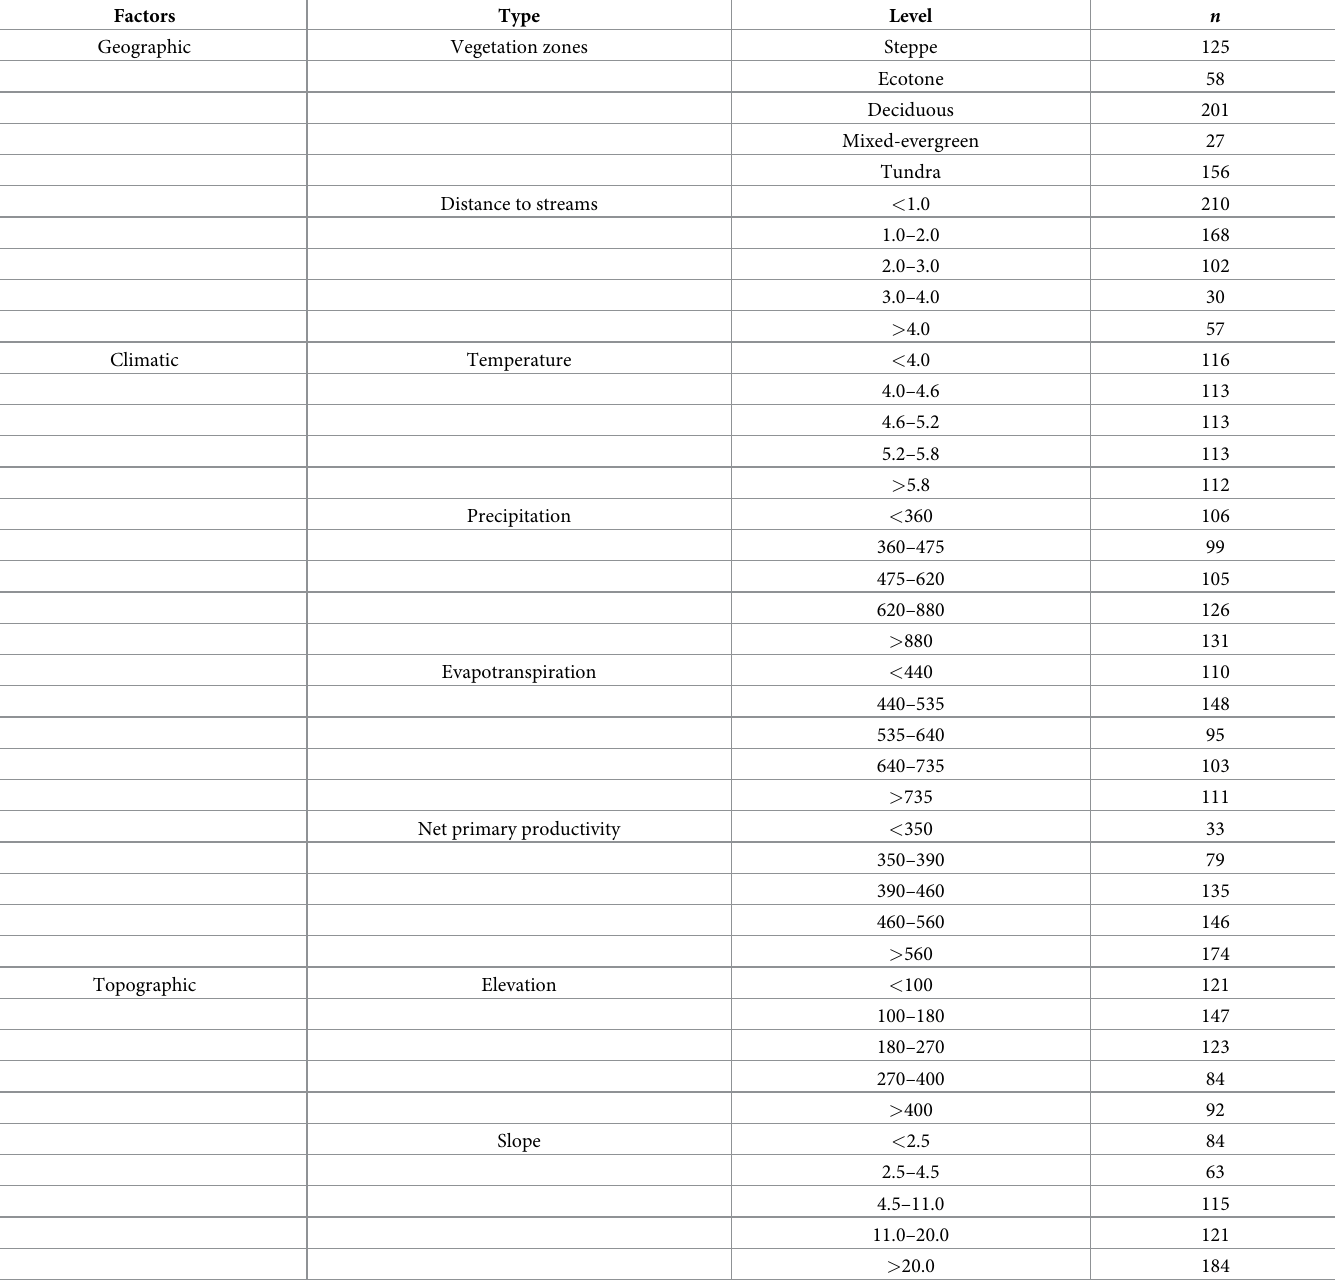
Table 1. Hexagon quantity (total of 567 for the whole study area) obtained for each level of the analyzed geographic, climatic and topographic factors.